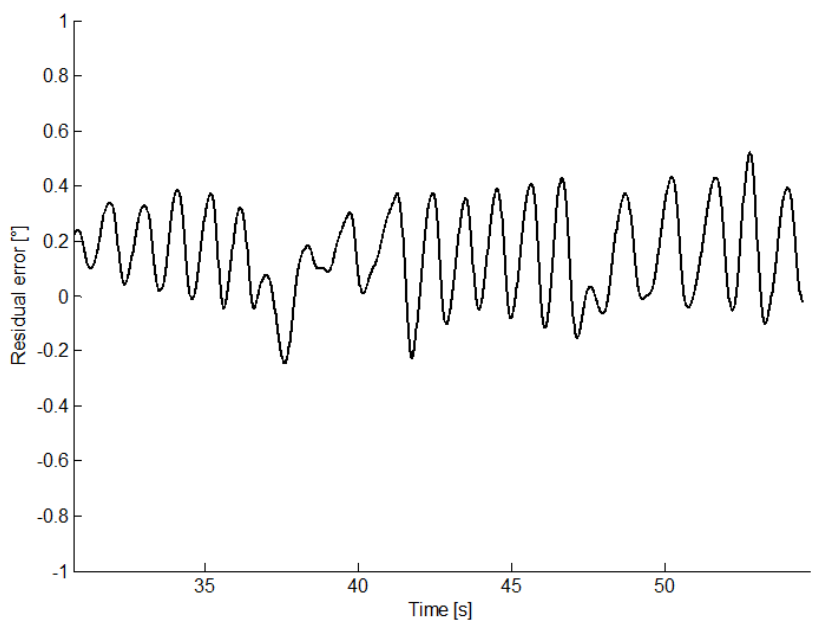
Figure 5. Residual error between the encoder output and sway angle estimated from the accelerometer output in the mechanical inverted